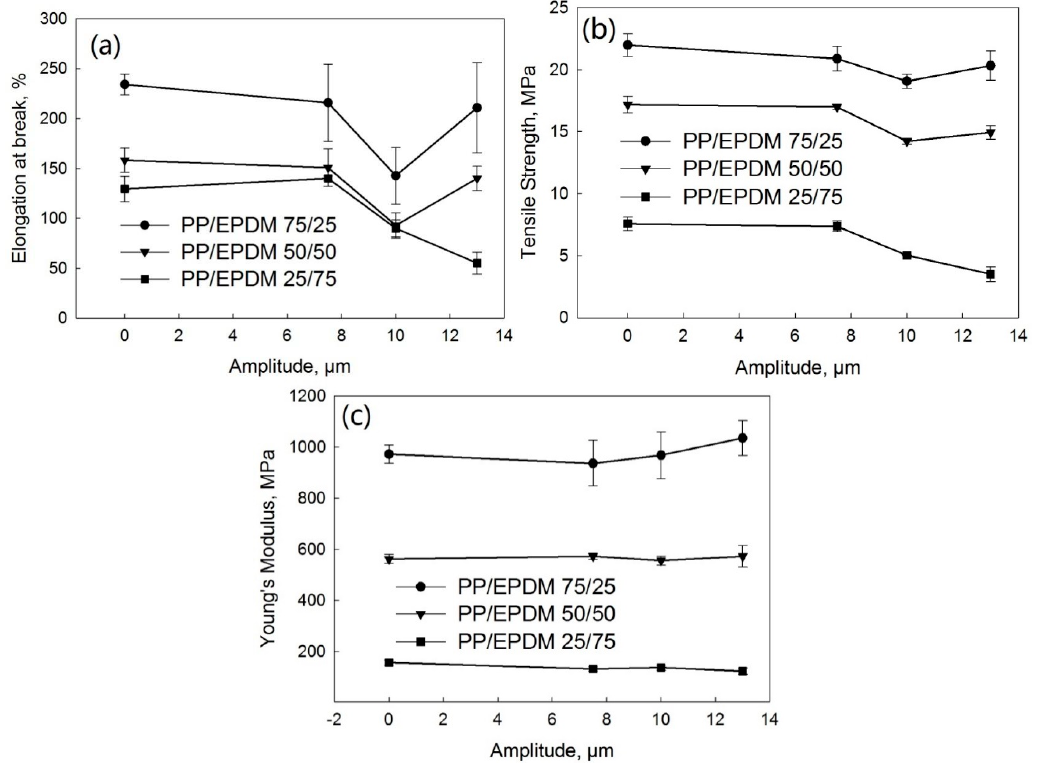
Figure 13. Elongation at break ( a ), tensile strength ( b ), and Young’s modulus ( c ) as a function of ultrasonic amplitude for PP/EPDM blends of different ratios prepared by the TS method.